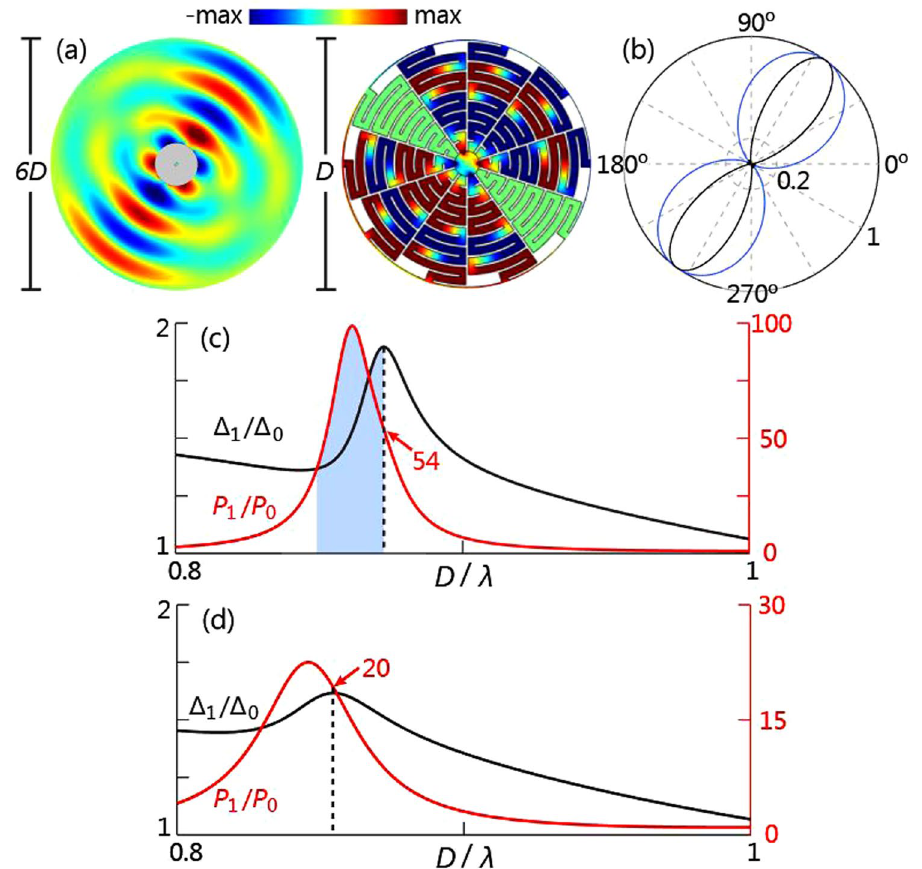
Figure 3. ( a ) With four sources encompassed by the enclosure, sound propagates bidirectionally with high directivity at wavelength 1.15 D , as shown by the simulated acoustic pressure field. ( b ) The normalized far- field directivity with the enclosure (black curve) and without it (blue curve). The directivity maximum is enhanced 18.4 dB by the presence of the enclosure. ( c ) The directivity enhancement ( Δ 1 / Δ 0 , black curve) and the enhanced source’s radiation rate ( P 1 / P 0 , red curve). The maximum Δ 1 / Δ 0 is indicated by the vertical dashed line, while its corresponding